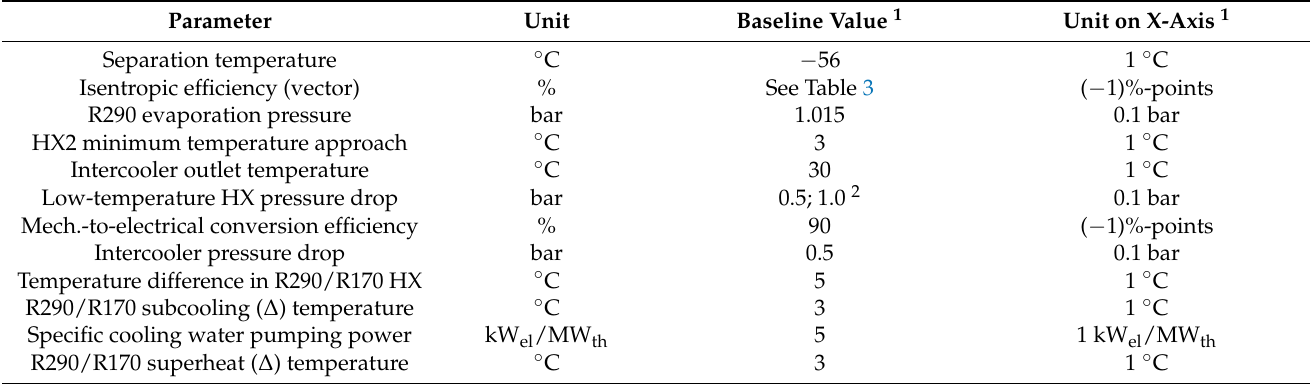
Figure 14. Results from the sensitivity analysis for specific power requirements. The legends rank the slope of curves in descending order. Supplementary data on axis values are given in Table 5. Table 5. Parameter descriptions for the sensitivity analysis.